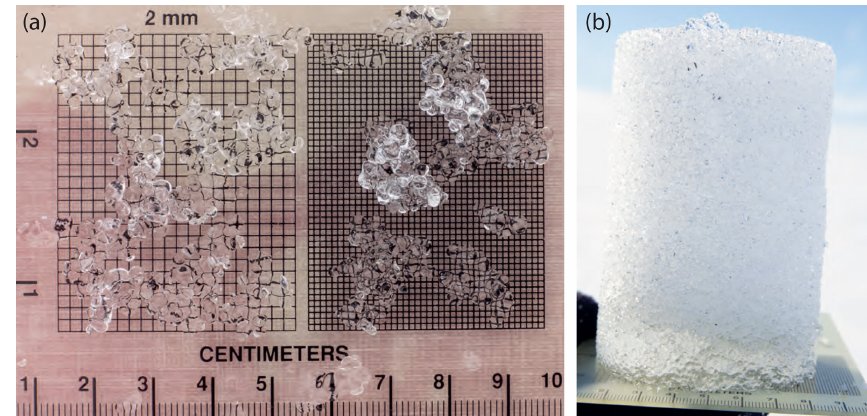
Figure 10. (a) Sample of slush matrix showing relatively homogeneous 2mm large rounded melt forms. (b) Sample of drained slush, showing water retention due to capillary forces (residual